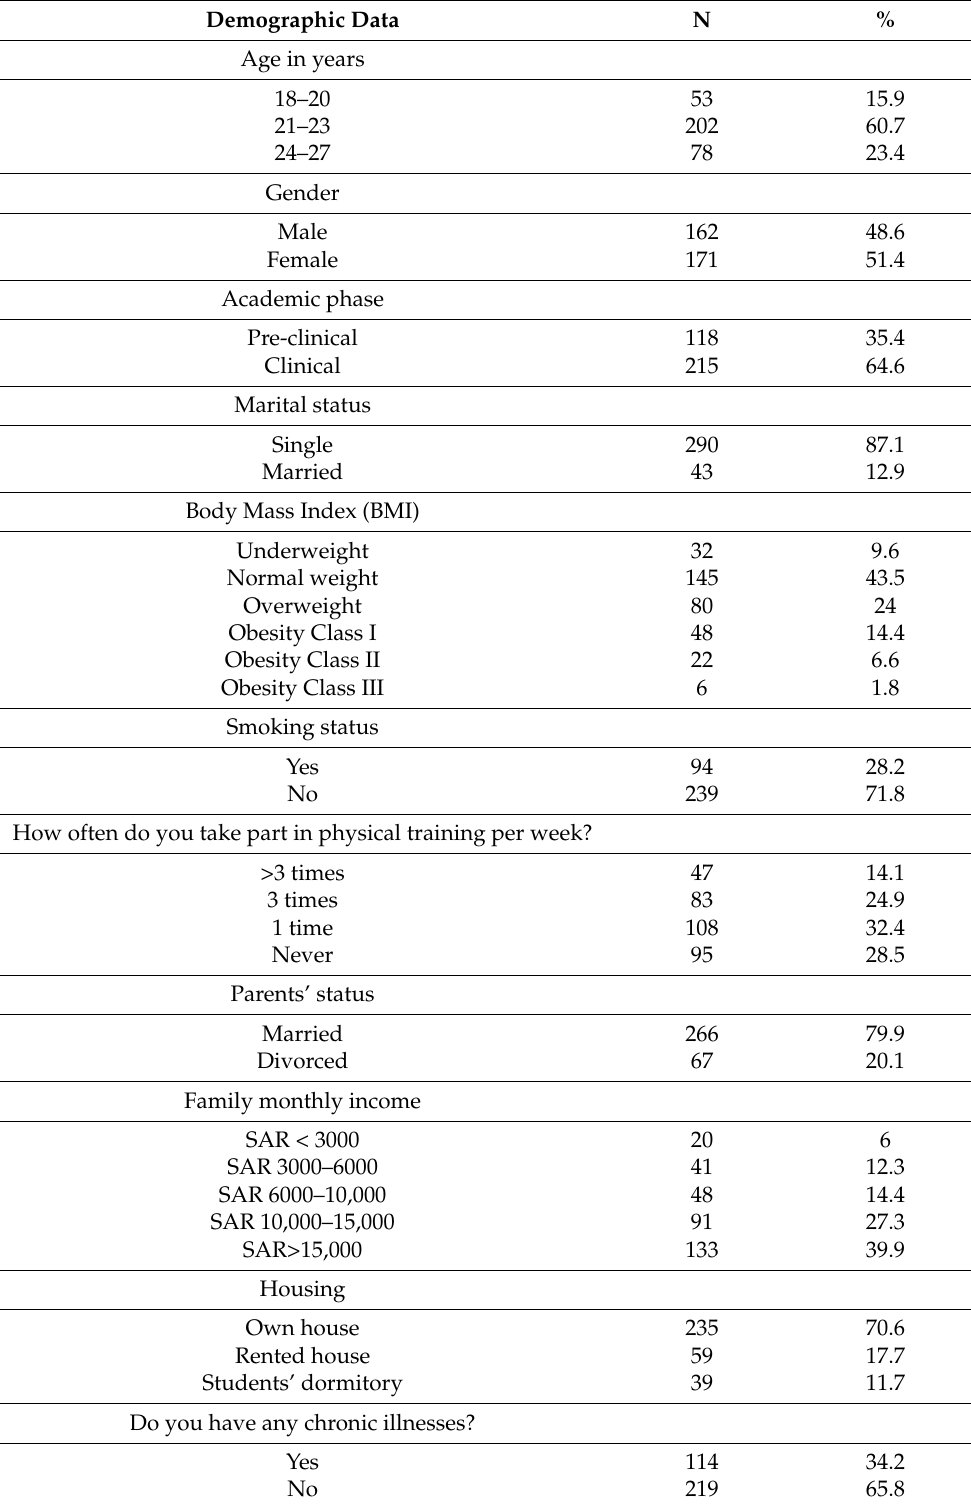
Table 1. Demographic data of medical students at King Khalid University, Saudi Arabia,